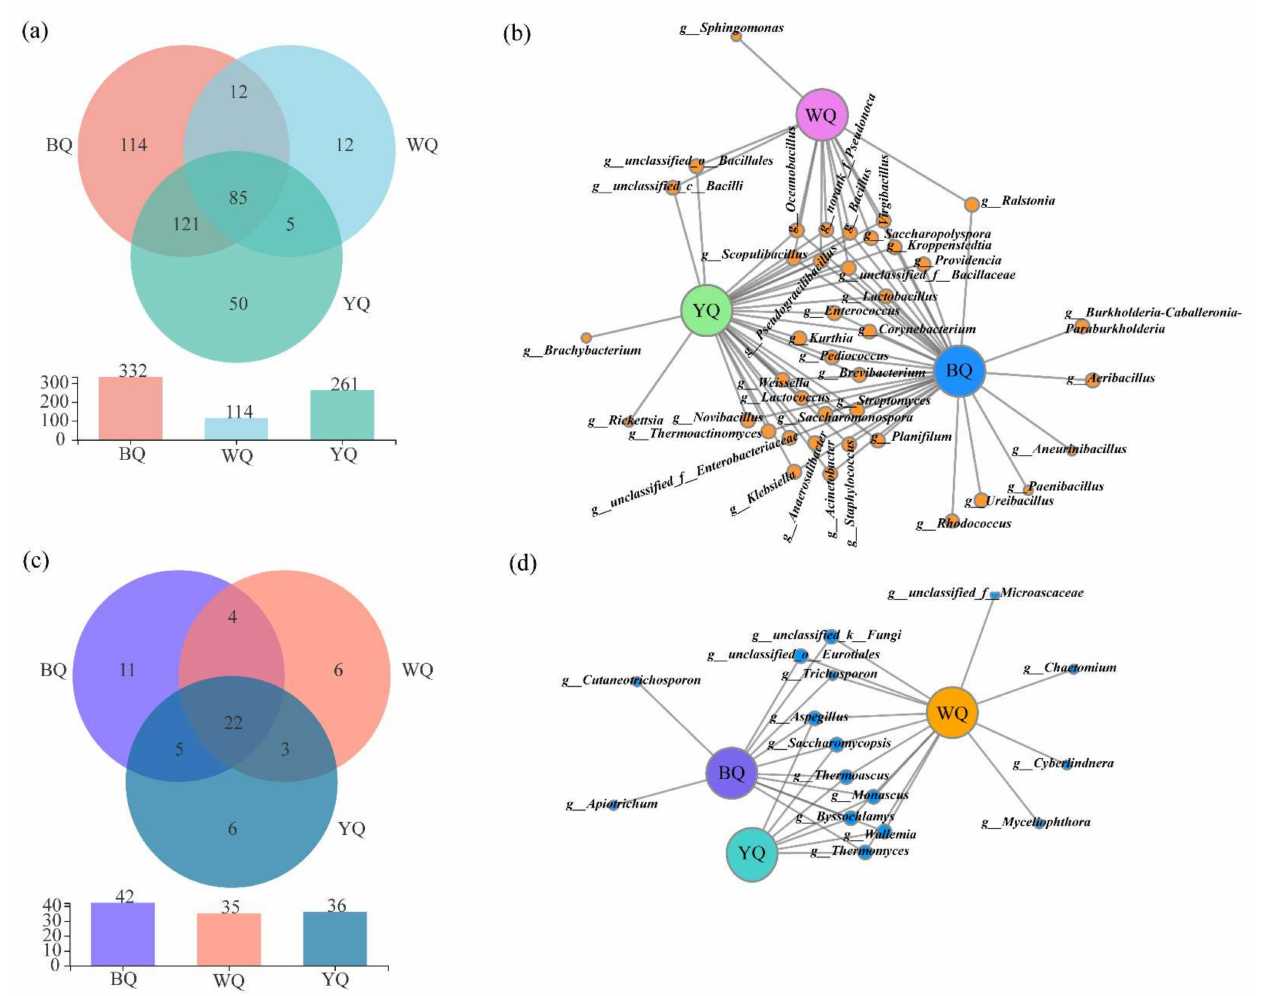
Figure 4. Venn diagram of the OTUs; ( a ) bacteria and ( c ) fungi. The network graphs show the common and unique ( b ) bacterial and ( d ) fungal